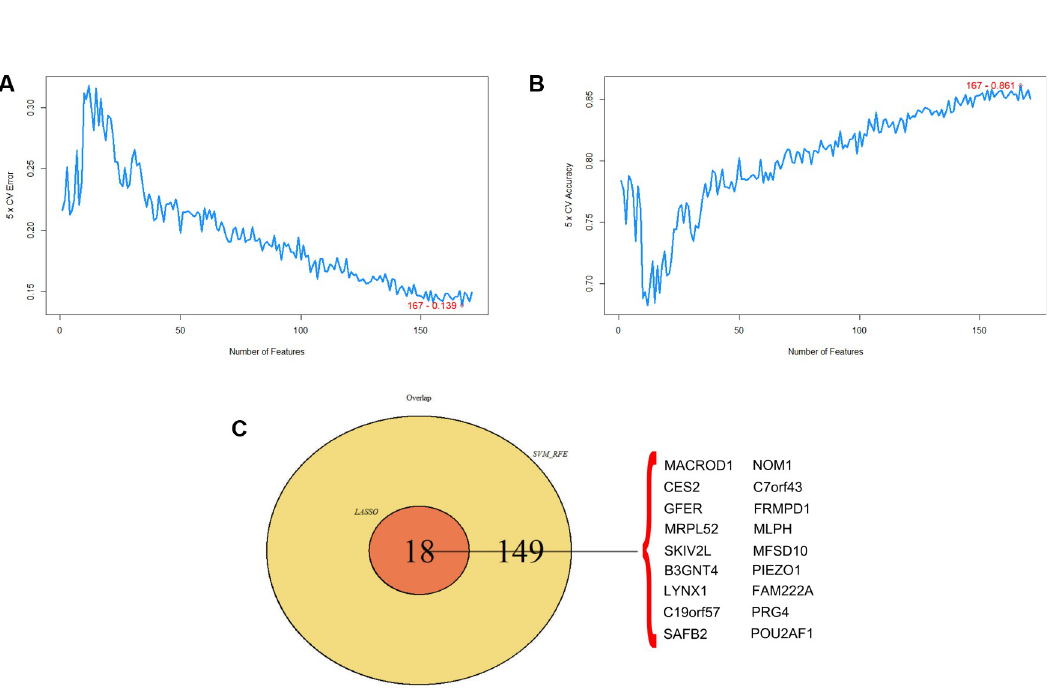
Fig 8. MSVM-RFE algorithm for screening key genes. (A)Shows the error rate of the SVM model (B) Shows the accuracy of the SVM model (C)The Venn diagram shows the same key genes obtained by the two algorithms.